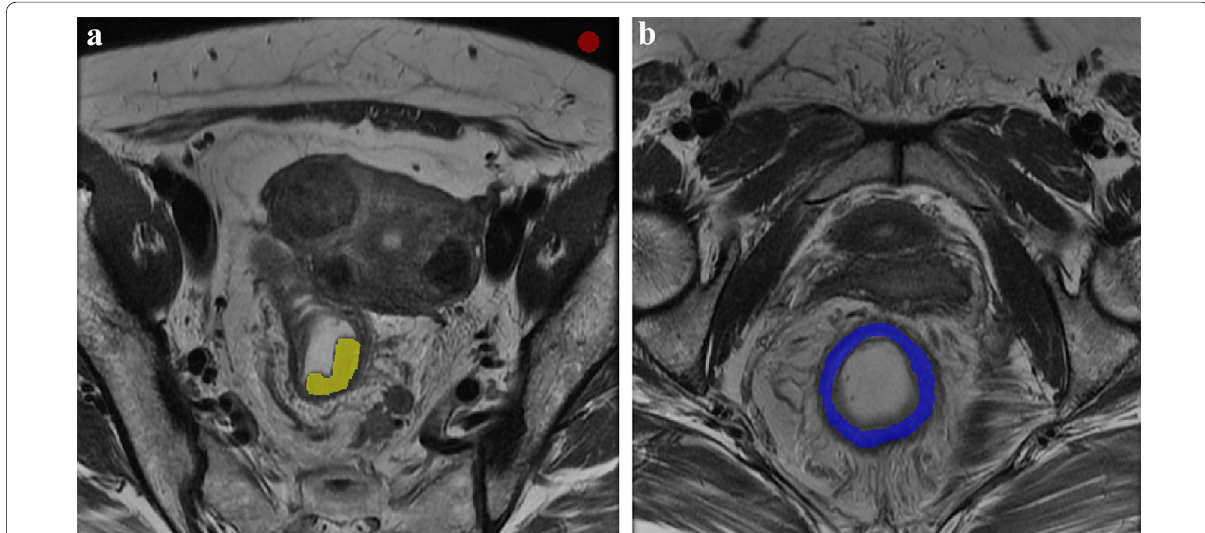
Fig. 3 Signal‑to‑noise ratio (SNR) and contrast‑to‑noise (CNR) were calculated based on three regions of interest (ROIs). The yellow ROI represents the tumor, which was delineated slice by slice along the tumor margin. The red ROI on background was placed within the field of view but outside the body surface. The blue ROI represents normal tissue, which was drawn in normal rectum tissue at a single slice. The mean and standard deviation of the signal intensity were obtained from each ROI to calculate SNR and